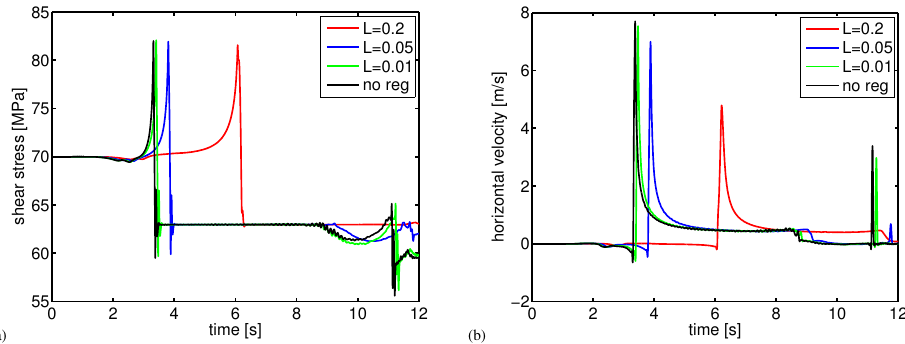
Fig. B1. Influence of Prakash–Clifton regularization on the ADER-DG solution of the ill-posed bimaterial problem TPV7. Time series of Fig. 17. Influence of Prakash-Clifton regularization on ADER-DG solution of the ill-posed bimaterial problem stress and velocity at a surface location on the far side of the fault above the nucleation zone for different values of the characteristic TPV7. Time series of stress and velocity at a surface location on the far side off the fault above the nucleation regularization length-scale L indicated in the legend (in zone for different values of the characteristic regularization length scale L indicated in the legend (in meters).